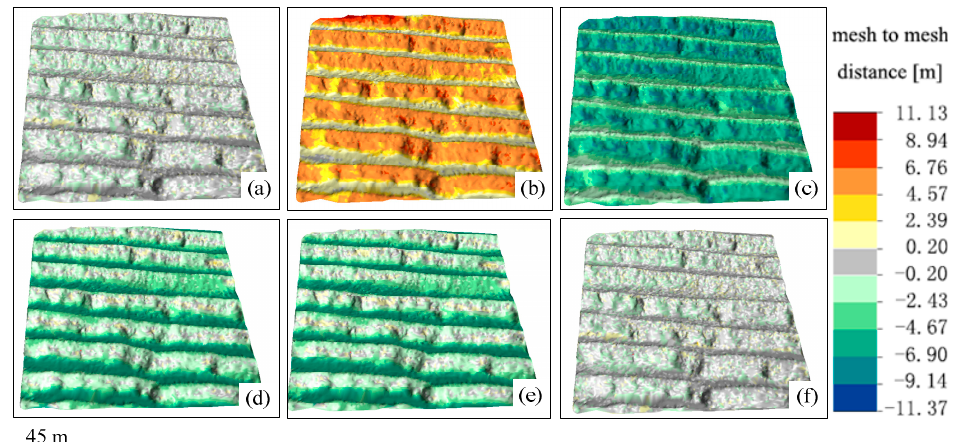
Figure 8. Distance map of b1 area in site B between the two temporal TLS surveys achieved by ( a ) the manual-based, ( b ) Super4PCS, ( c ) MSSF-Super4PCS, ( d ) Super4PCS+ICP, ( e ) MSSF-Super4PCS+ICP, and ( f ) the proposed method.